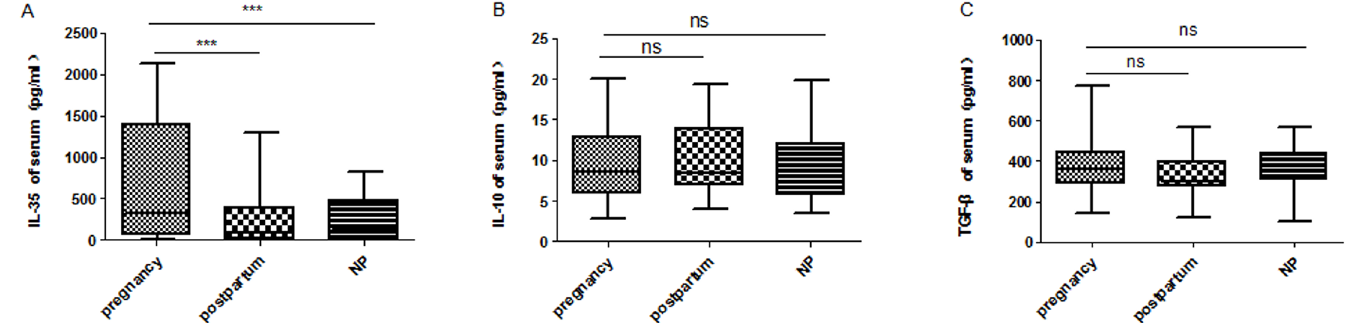
Fig 1. The serum levels of inhibitory cytokines (A) IL35, (B) IL10, and (C) TGF- β in pregnancy. These data show medians and percentiles over all patients throughout their pregnancies. NP: non-pregnant women; postpartum: postpartum healthy women; *** P < 0.001; ns: not significant.